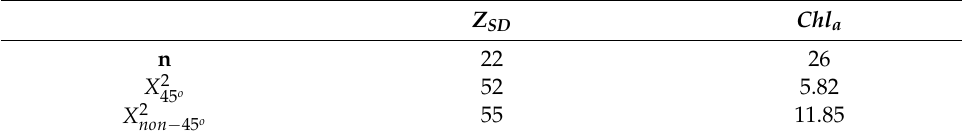
Table 10. Least-squares analysis for the and Z SD and Chl a